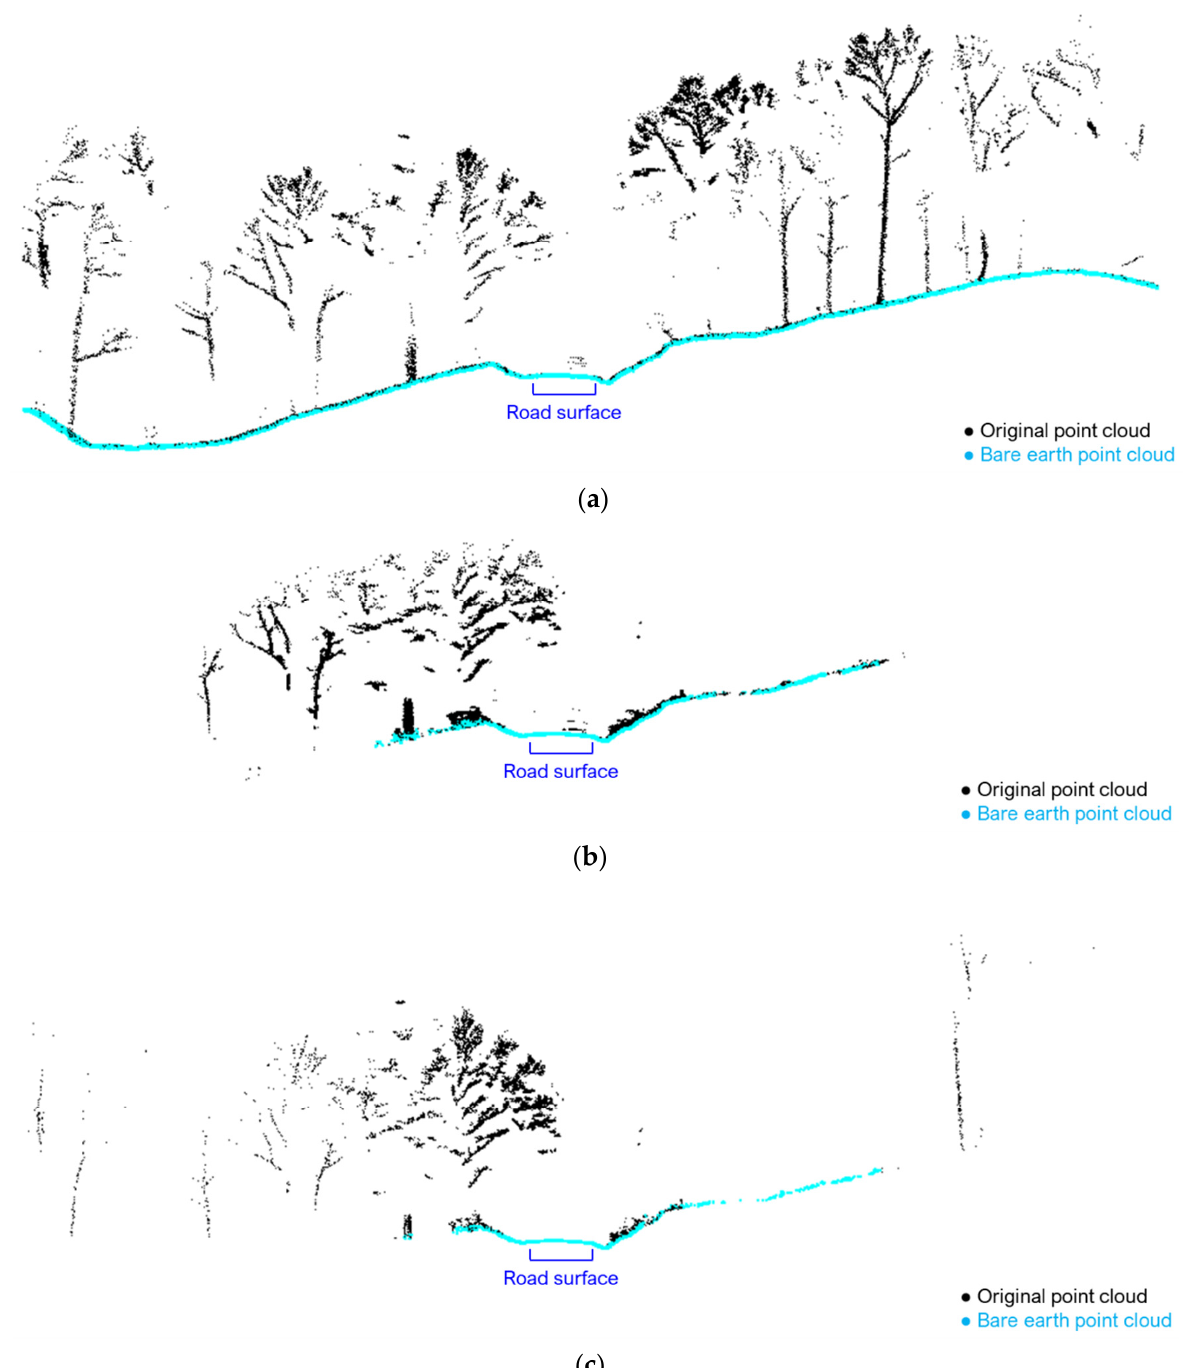
Figure 11. Side view of a cross-sectional profile at location PA1 showing the original and bare earth point clouds from ( a ) UAV, ( b ) PWMMS-HA, and ( c ) Mobile-pack.